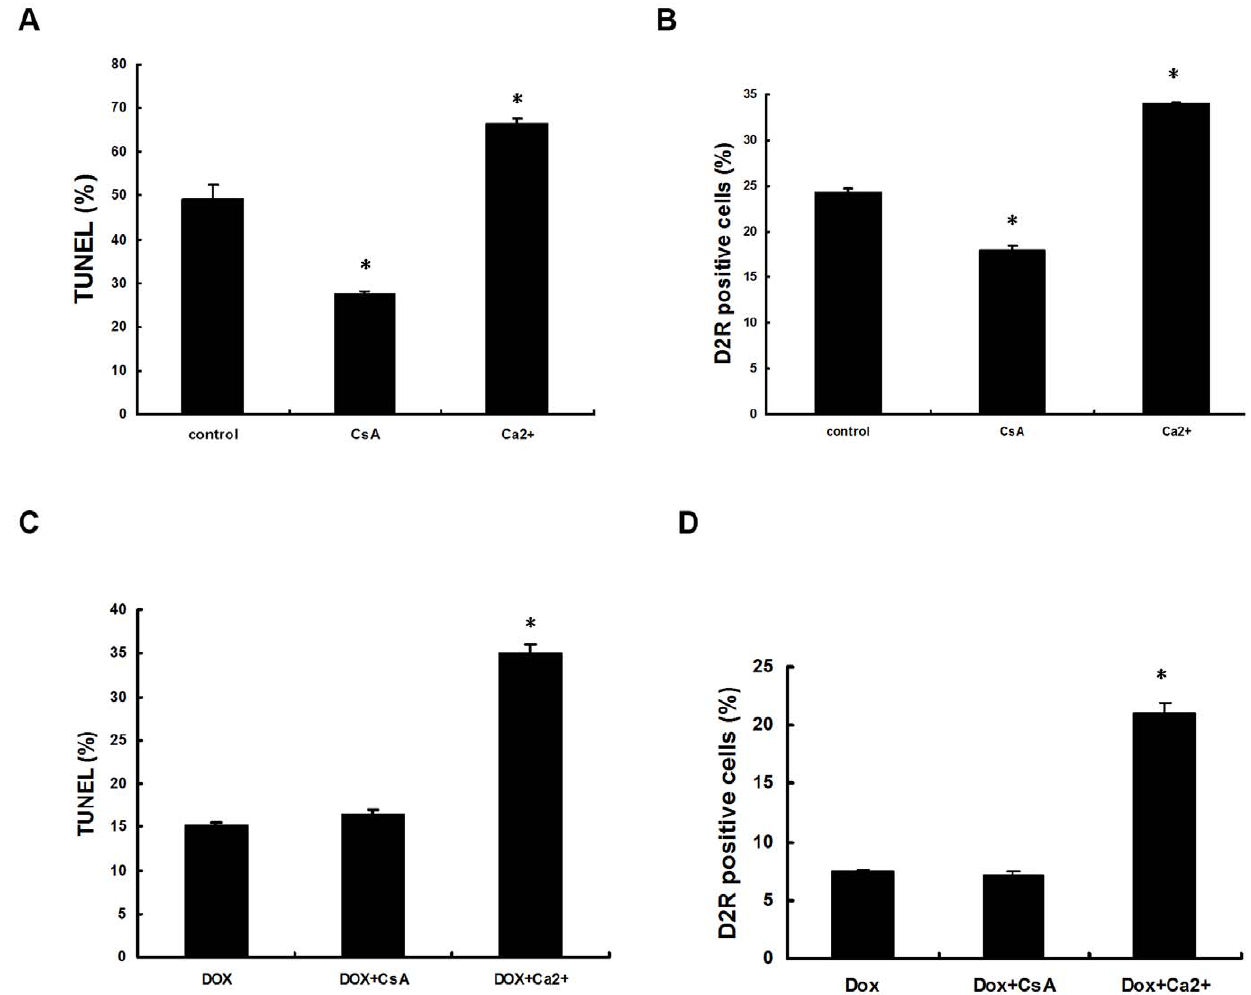
Figure 8. Calcineurin is downstream of Hsp90 in apoptosis. C. albicans cells were exposed to 1.25 mM H 2 O 2 for 3 h in the absence or presence of CaCl 2 (1 mM) or CysA (0.08 m M). (A) and (B) are wild-type HSP90/HSP90 strain cells. (C) and (D) are tetO-HSP90/hsp90 cells in the presence of 20 m g/ml DOX. Results are shown as mean 6 SD from three independent experiments. * indicates p , 0.05 compared to the wild-type